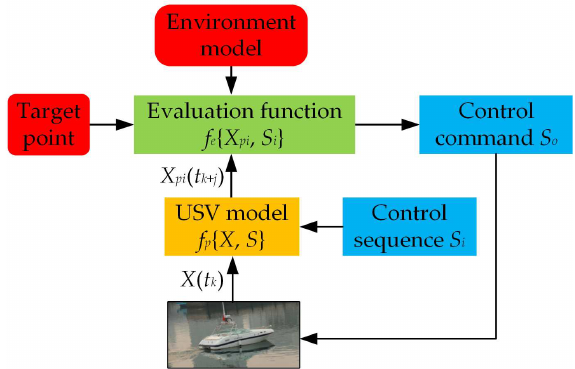
Figure 3. The CAS based on